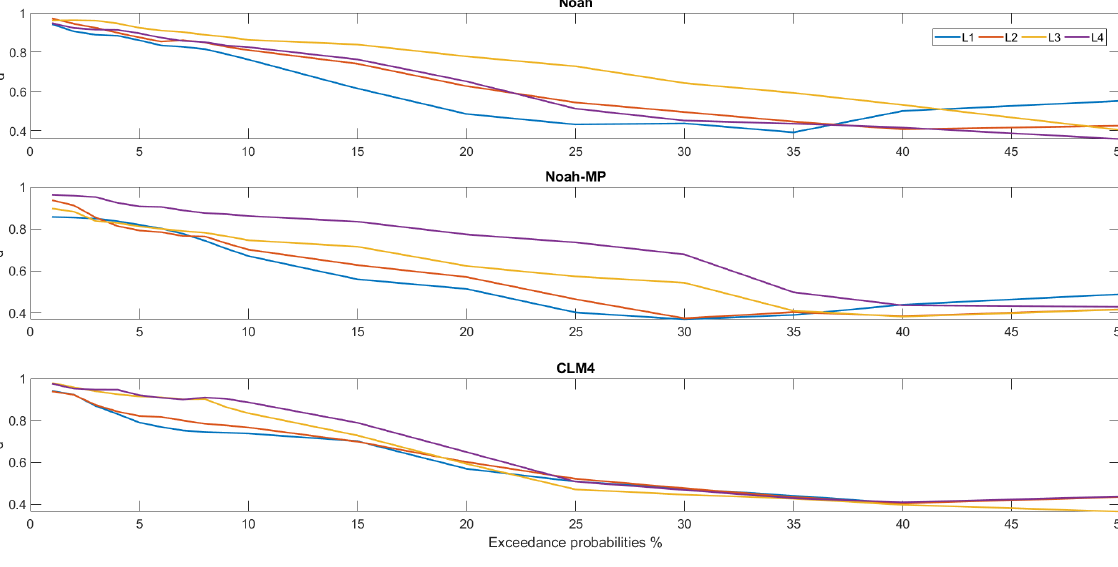
Figure 8. Model d